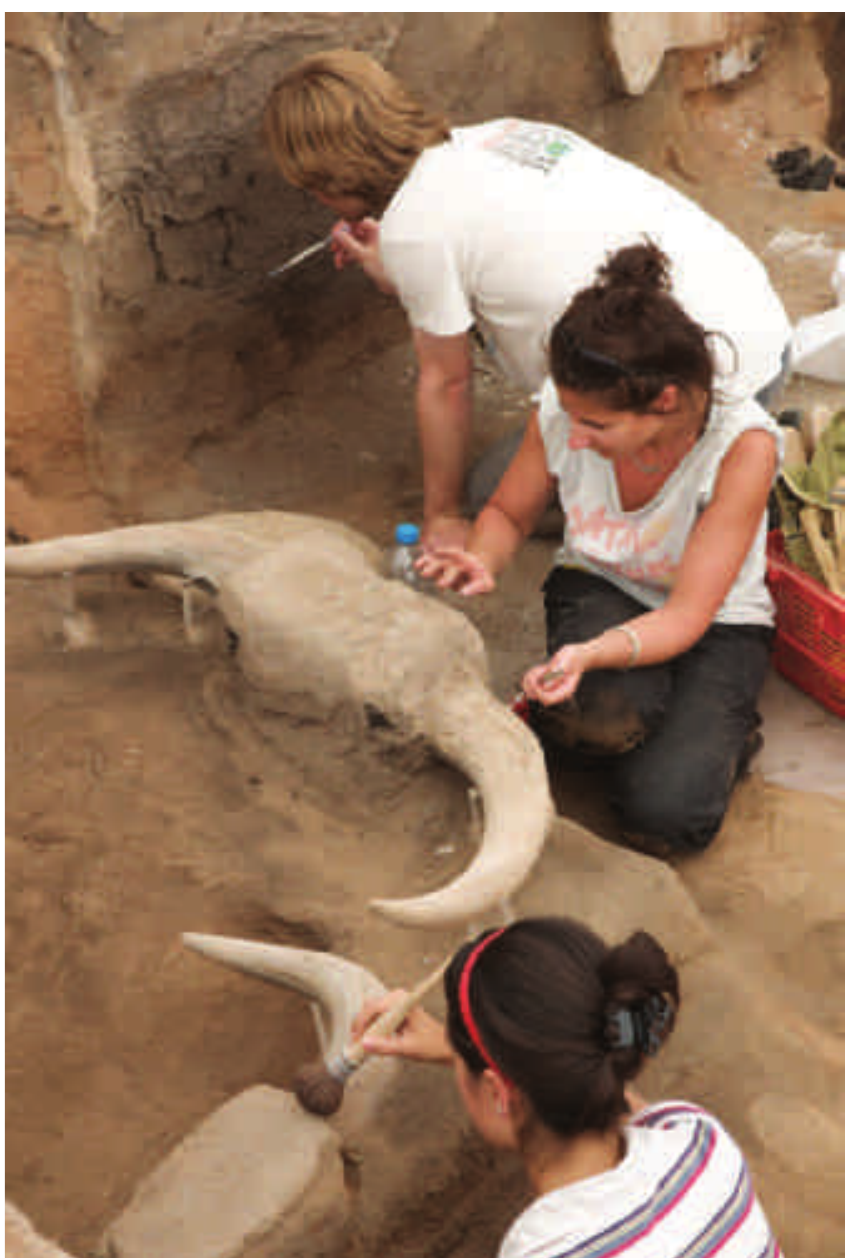
Figure 4 Conservators working on the installation in Building